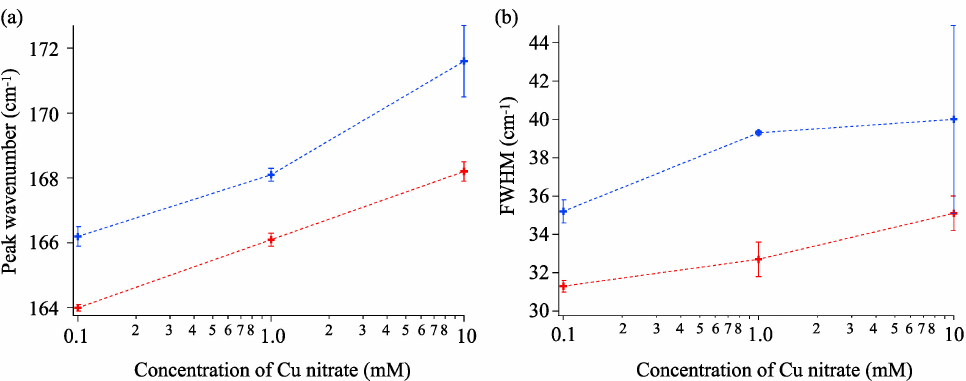
Figure 8. Concentration dependence on ( a ) peak wavenumber of Raman E g mode and ( b ) spectral width. Red and blue indicate coating and powder samples, respectively.